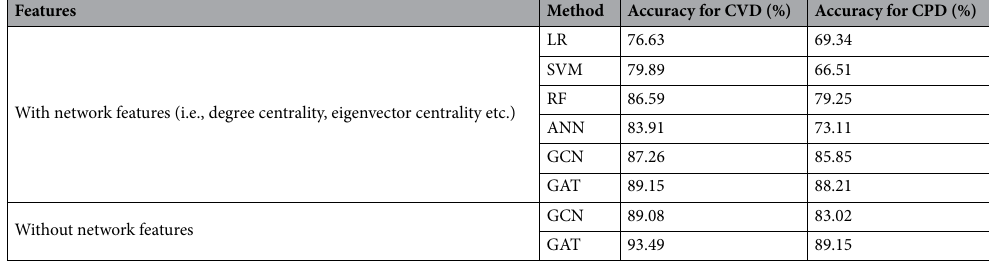
Table 5. The accuracy measure of different models for CVD and CPD without the consideration of edge weight in the patient network.